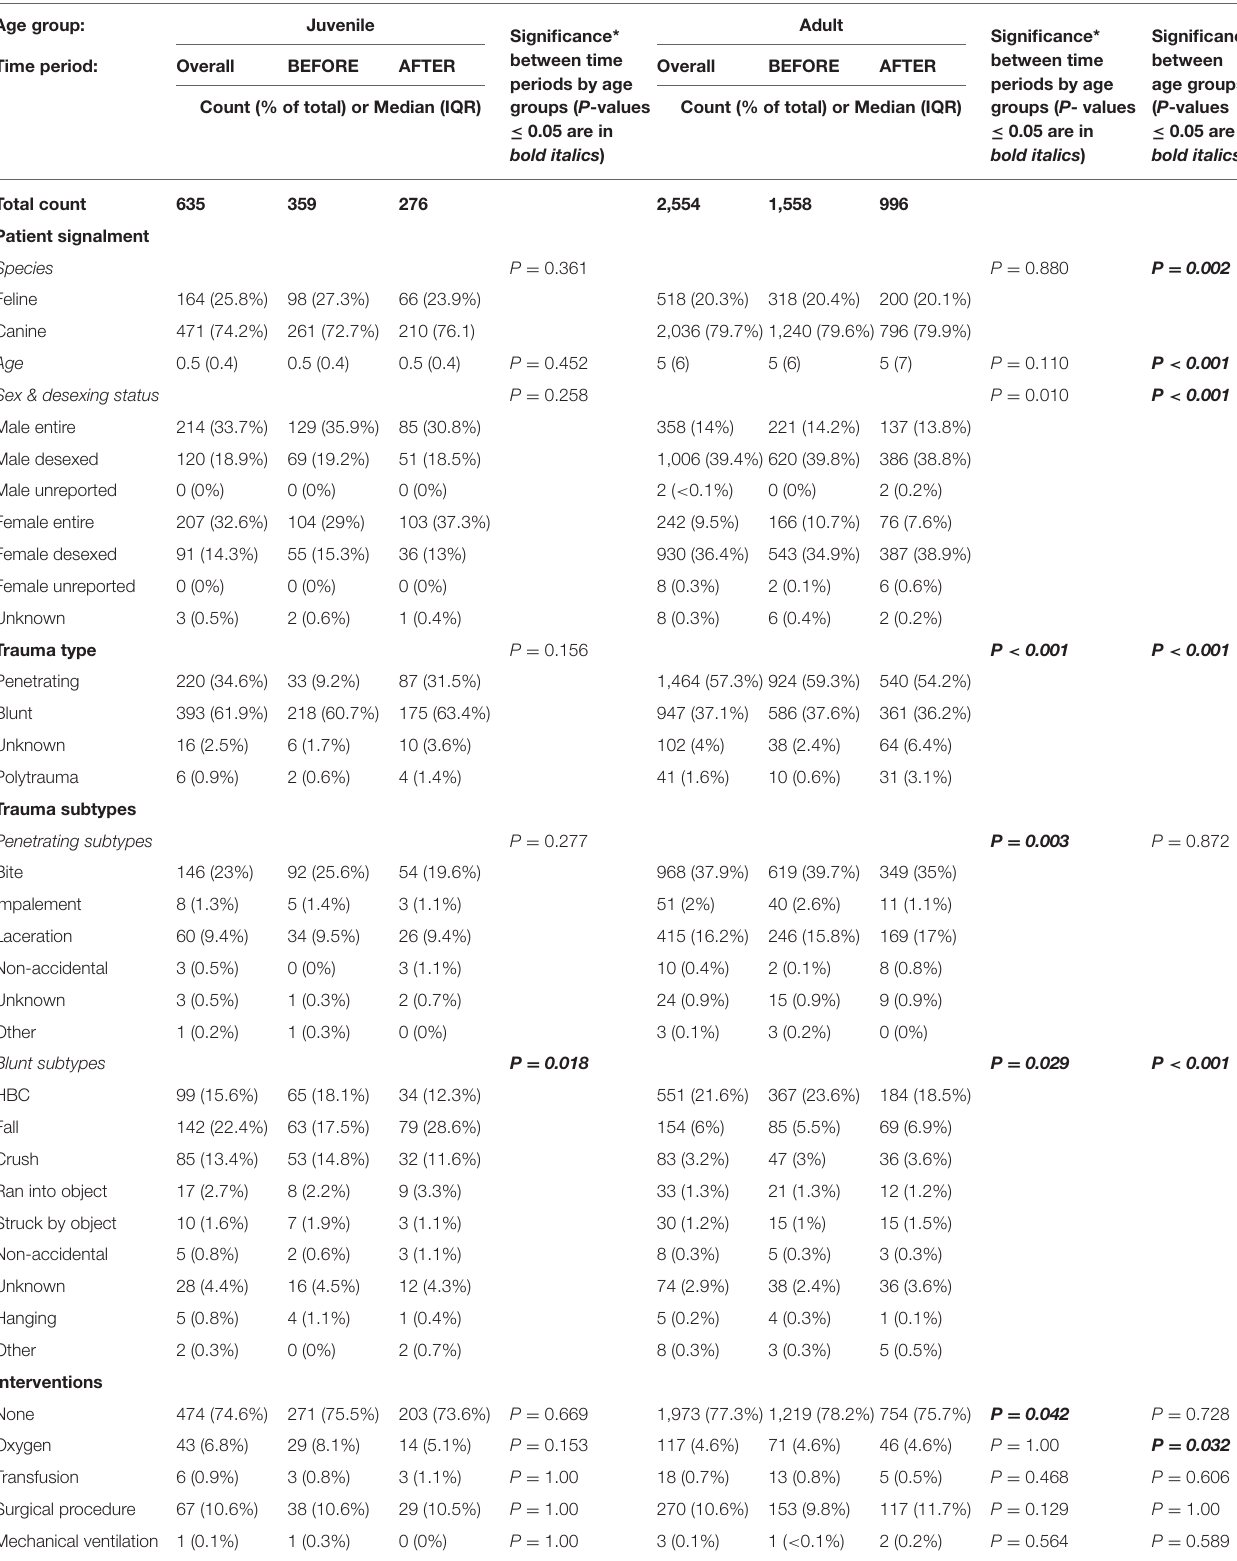
TABLE 4 | Patient characteristics, interventions, and outcomes by age